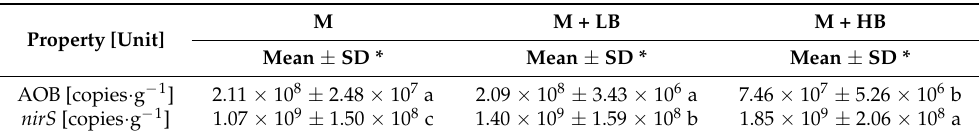
Table 4. Microbial properties of matured manures—ammonium-oxidizing bacteria (AOB), denitrify- ing bacteria ( nirS